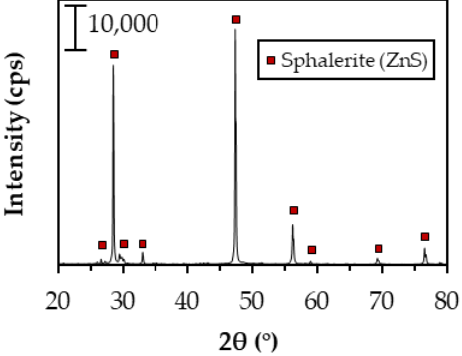
Figure 1. XRD pattern of a mineral specimen of ZnS.